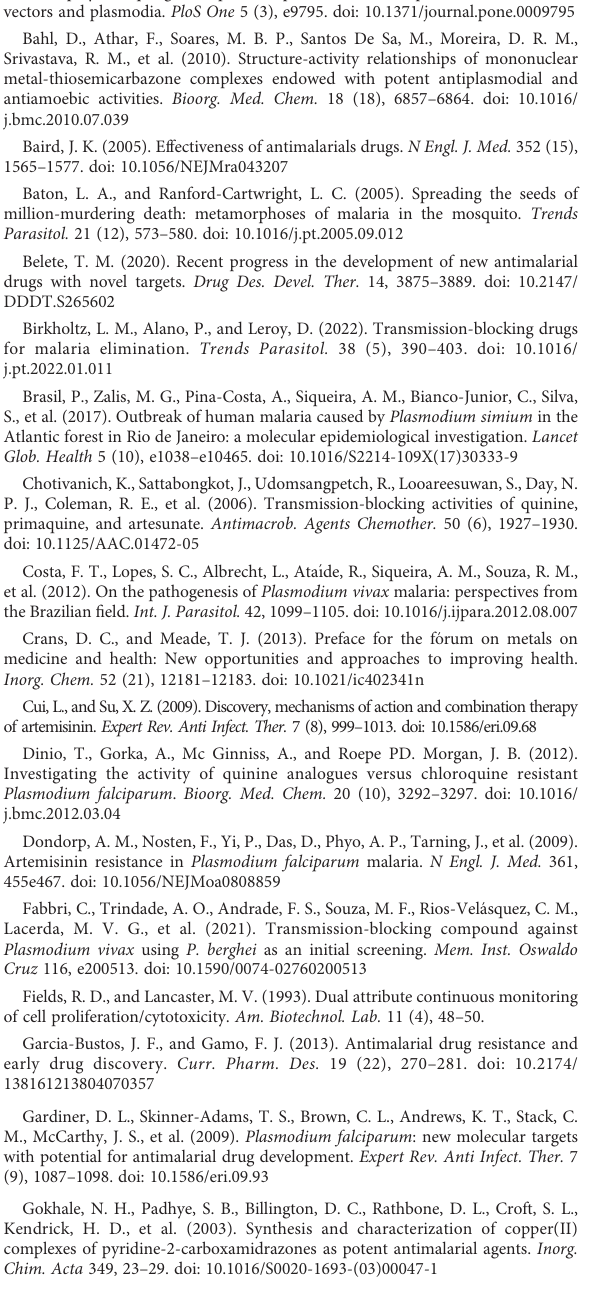
Tableu Public (2022) (Mala ́ ria – Brasil: Ministe ́ rio da Sau ́ de). Available at: https://public.tableau.com/app/pro fi le/mal.ria.brasil (Accessed September 12,